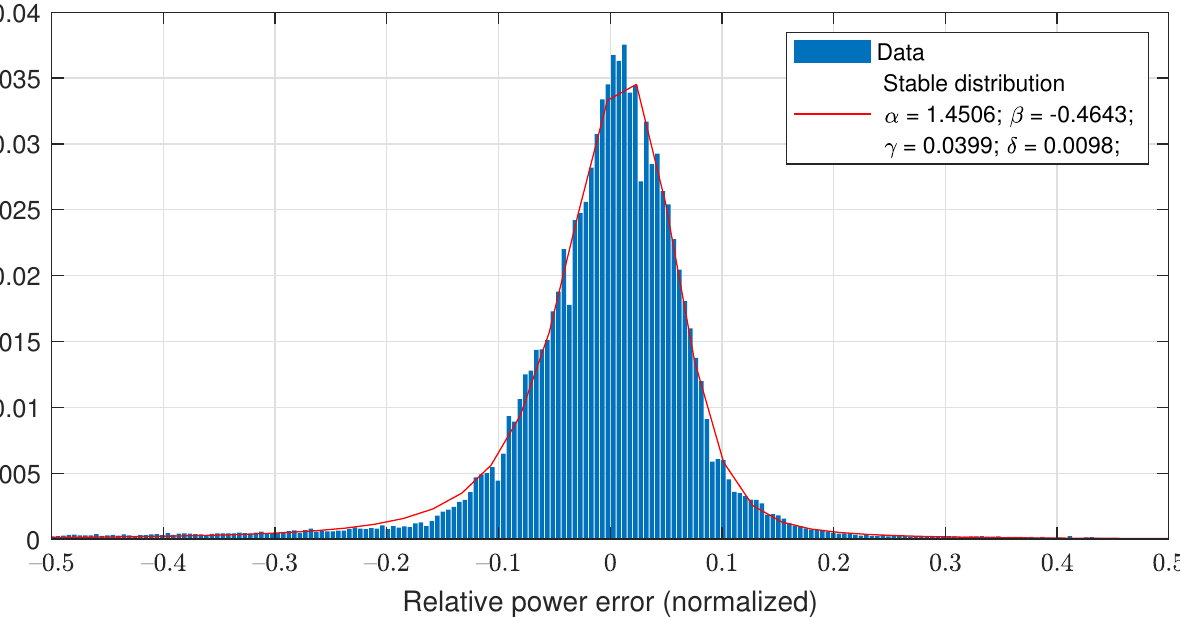
Figure 7. Distribution of the relative error between modeling and the measured thermal powers (fitted by a stable